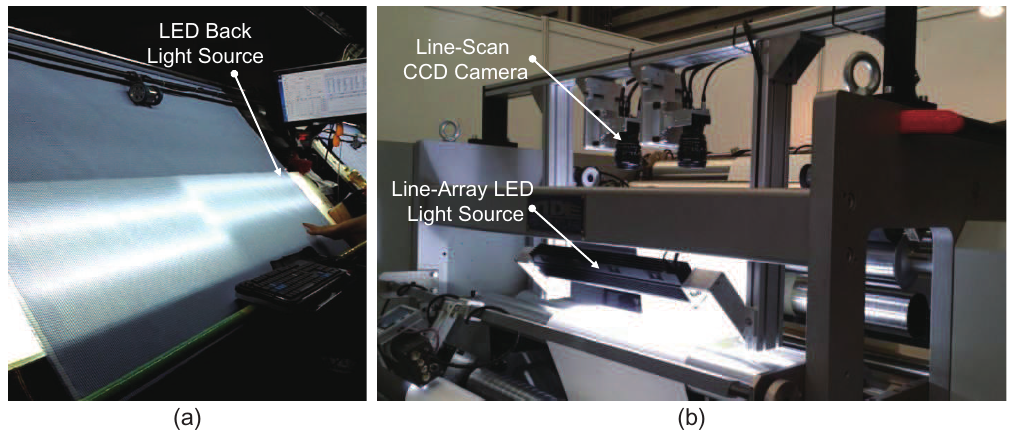
Figure 1. Fabric defect detection by ( a ) manual and ( b ) [4] automated optical inspection